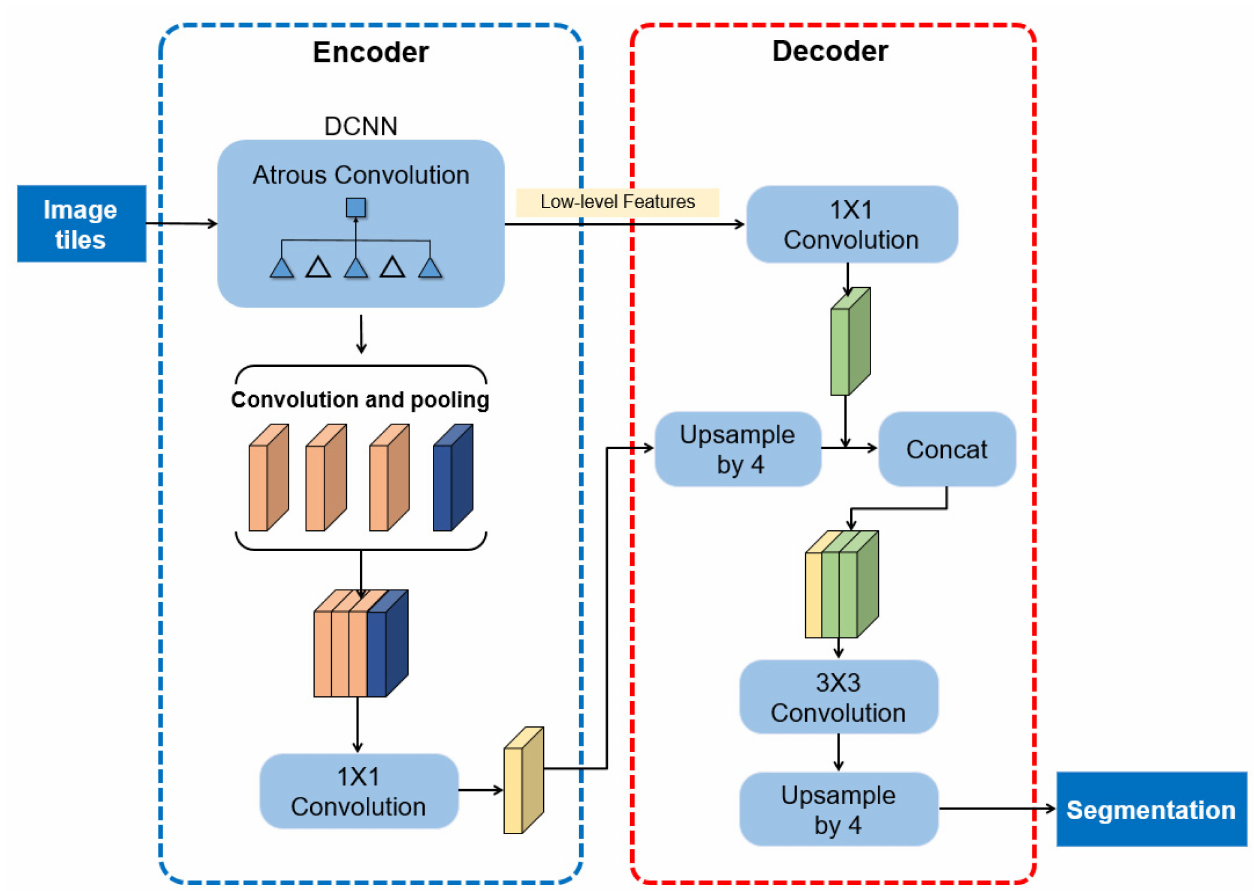
Figure 4. The DeepLabV3+ architecture used in this